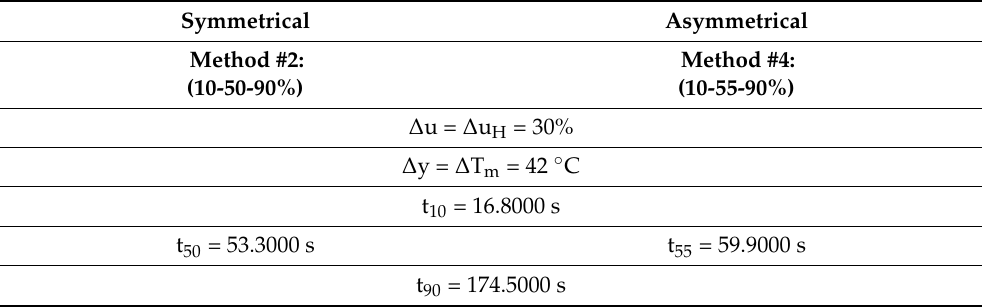
Table 24. Process information for methods #2 and #4, respectively, collected from the process reaction curve for fractional-order model identification of the thermal process.